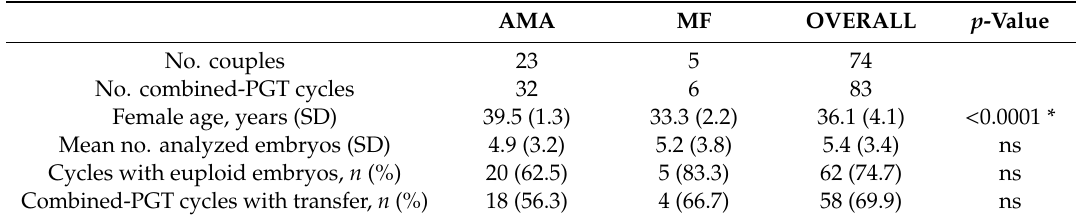
Table 3. Results per cycle in the advanced maternal age (AMA) and male-factor infertility (MF) groups. AMA MF OVERALL p